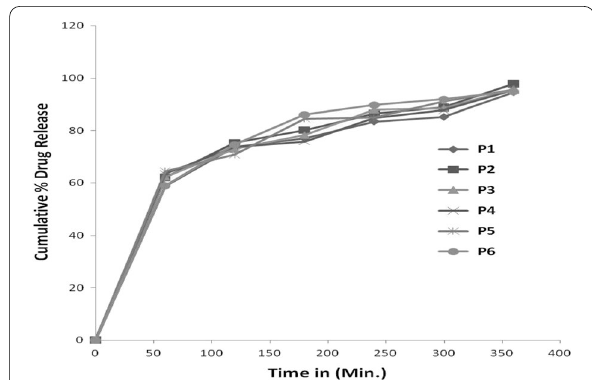
Fig. 5 In vitro release of Diclofenac sodium from various chitosan-based PEC beads containing Diclofenac sodium in phosphate buffer (pH 6.8)